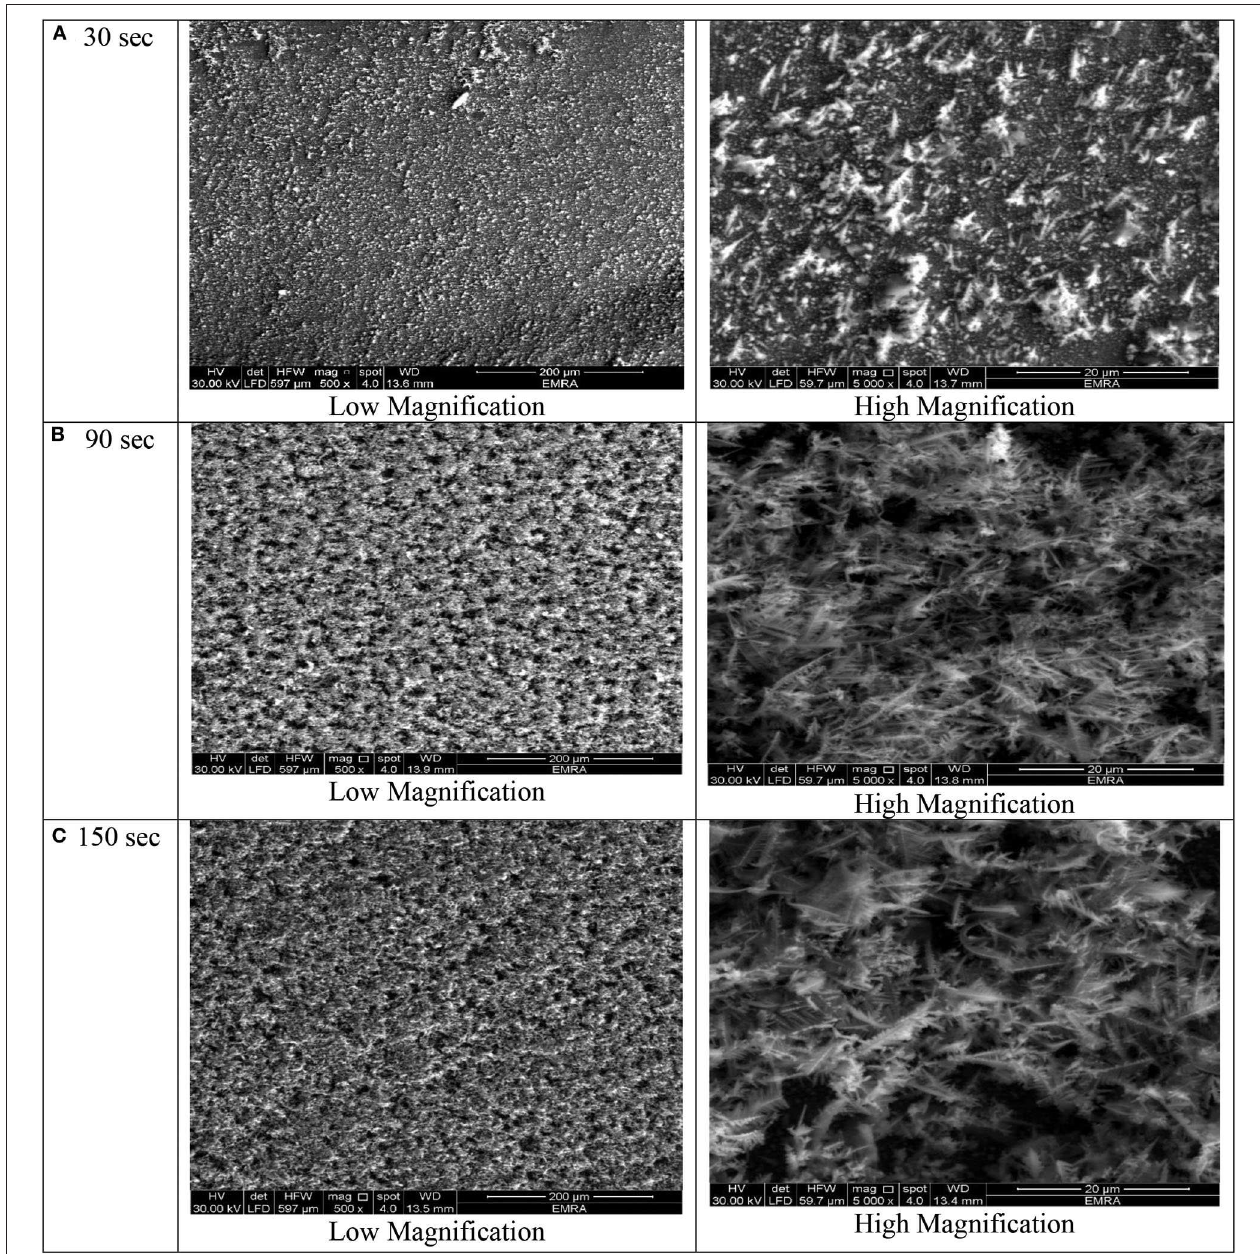
FIGURE 2 | SEM images of porous Ni–Cu layers electrodeposited on AISI 304 stainless steel for (A) 30s, (B) 90s, (C) 150s. at current density 1 A/cm 2 .